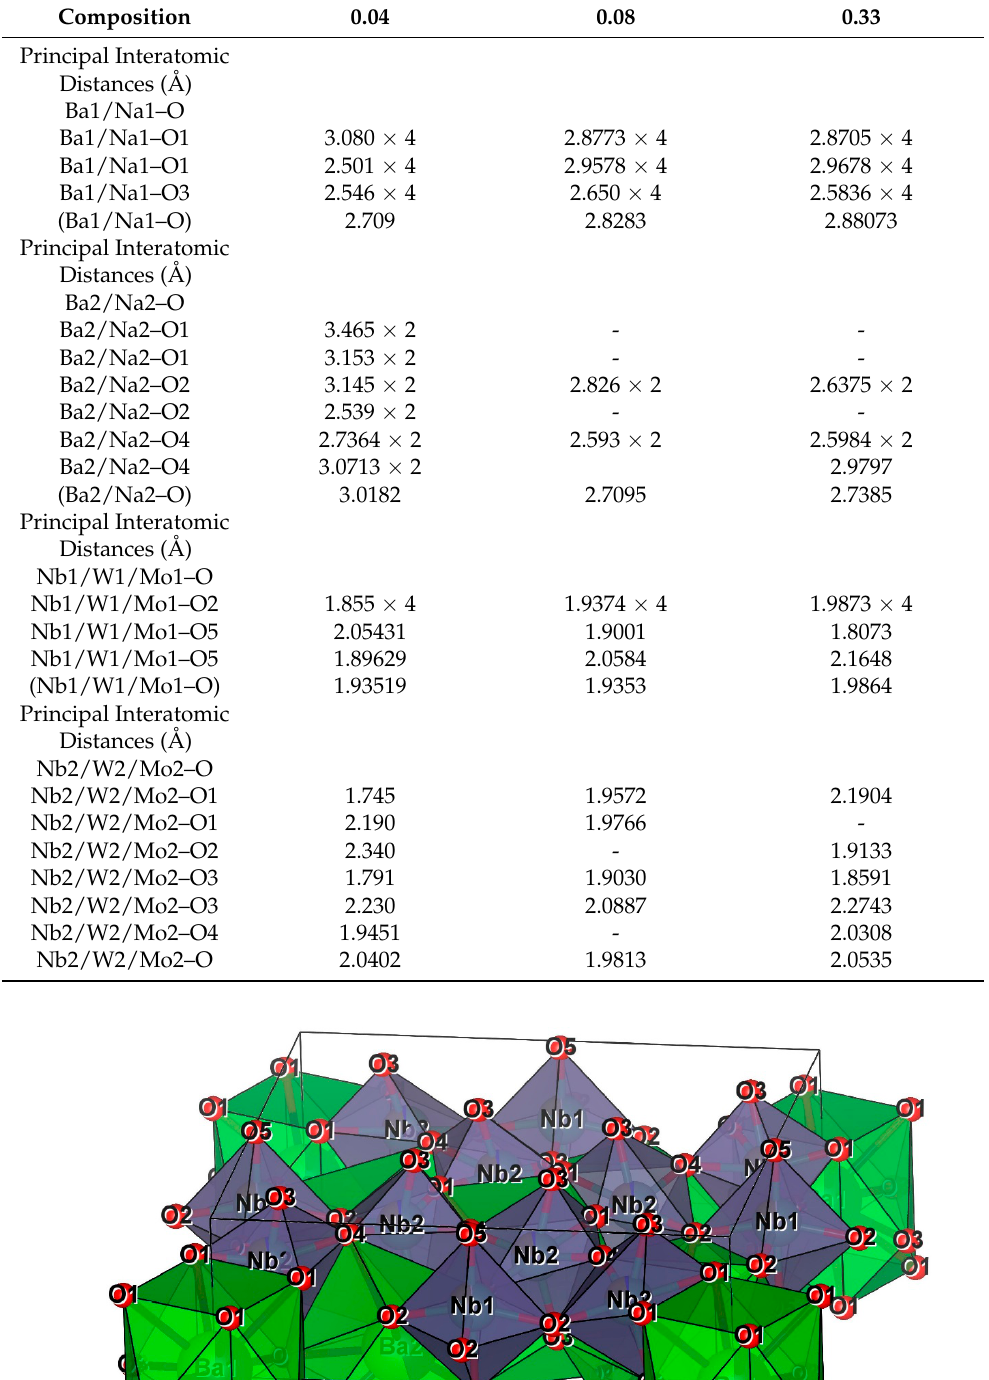
Table 3. Different interatomic distances (Å) of the crystalline phases of Ba 0.54 Na 0.46 Nb 1.29